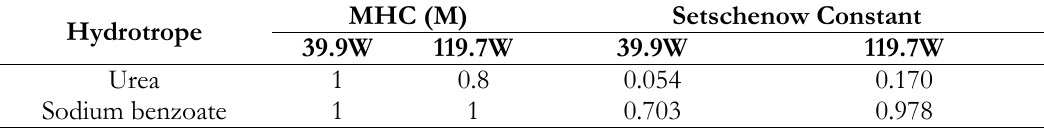
Tabel I. MHC and Setschenow Constant of